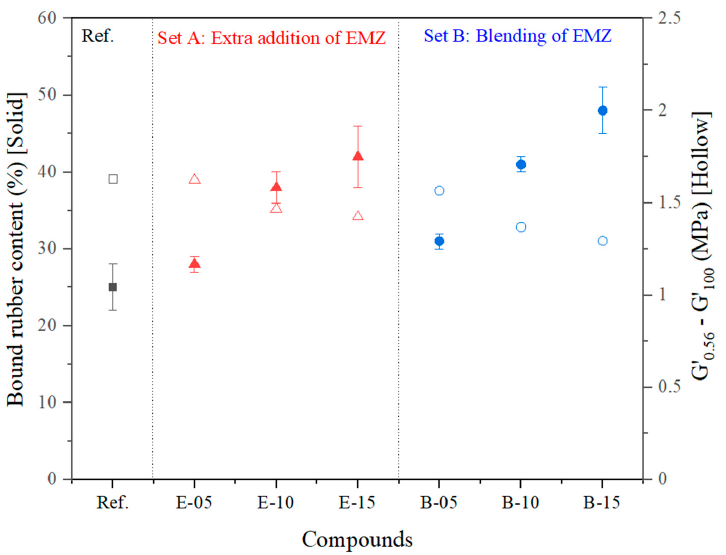
Figure 4. Influence of EMZ content on chemically bound rubber contents and Payne effect of sil- ica - filled NR compounds . EMZ was added via either extra addition (Set A) or blending (Set B) .